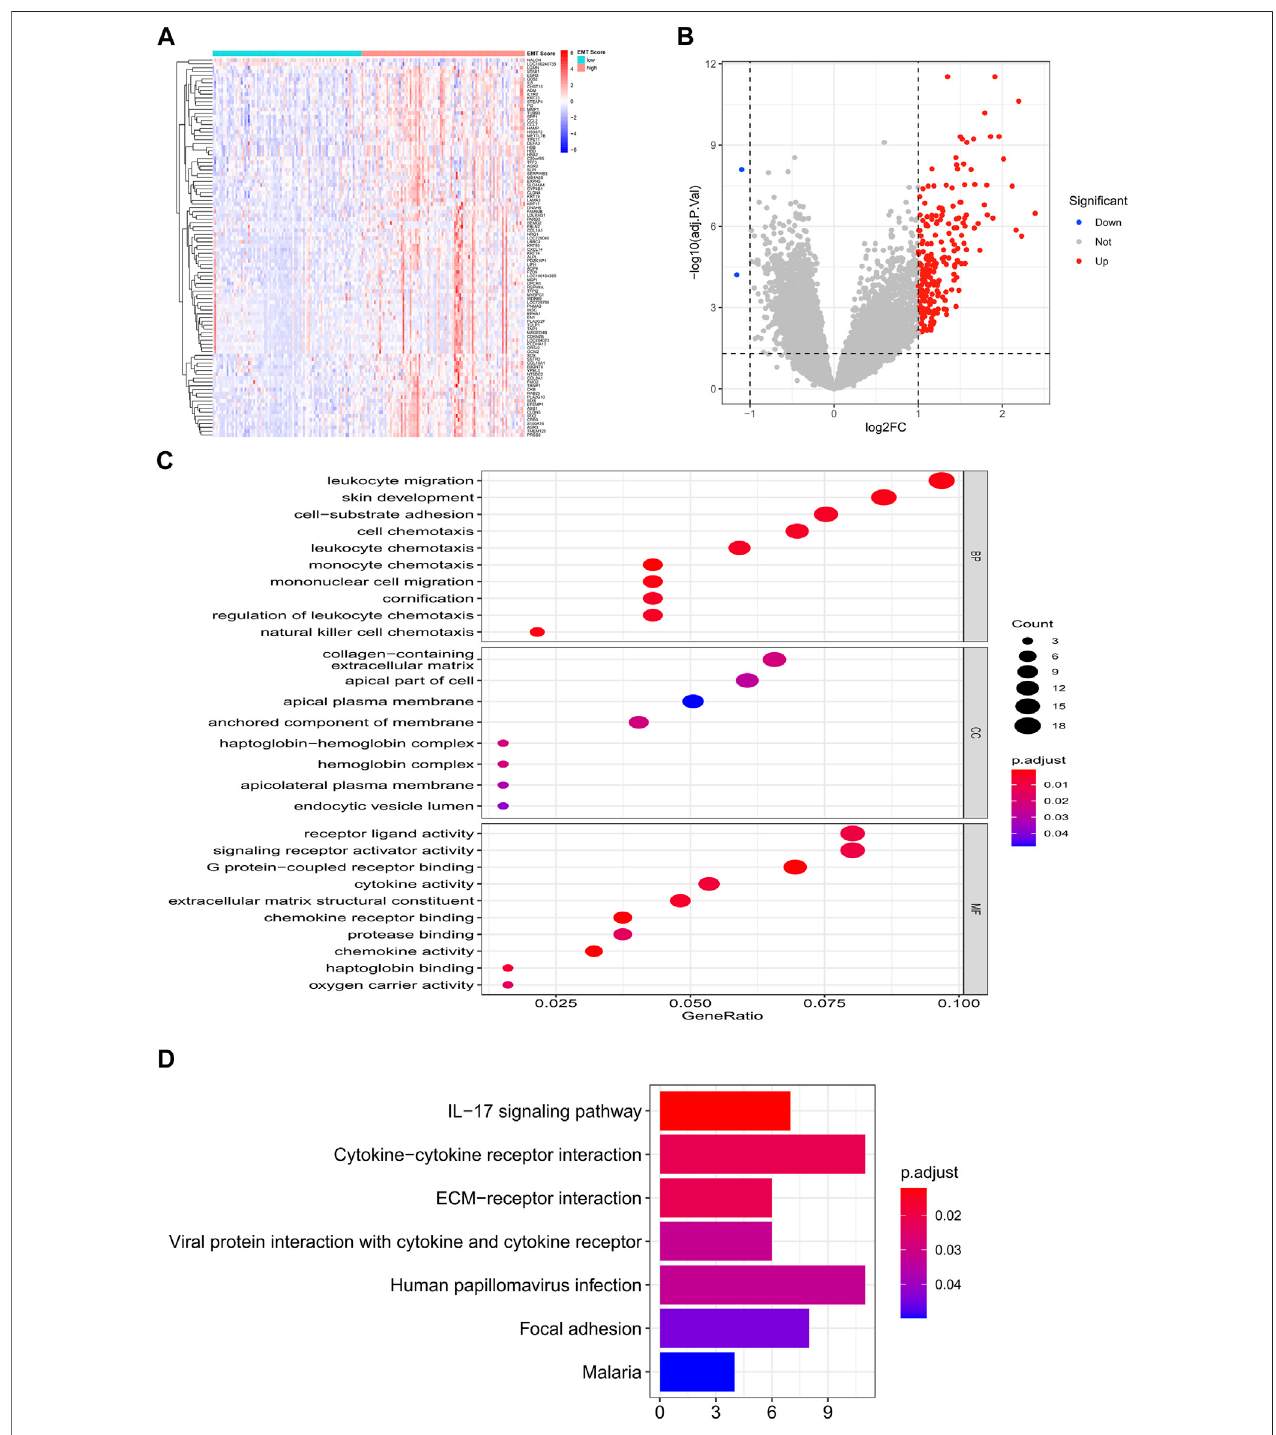
FIGURE2| Identi fi cationofEMT-related genesinthetrainingset. (A) Heatmap ofDEGsbetweenpatientsoftheEMTscore-highgroupandpatientsintheimmune score-low group. (B) Volcano plot of DEGs between patients of the EMT score-high group compared with patients in the immune score-low group. (C) GO enrichment analysis of EMT-related genes. (D) KEGG enrichment analysis of EMT-related genes.